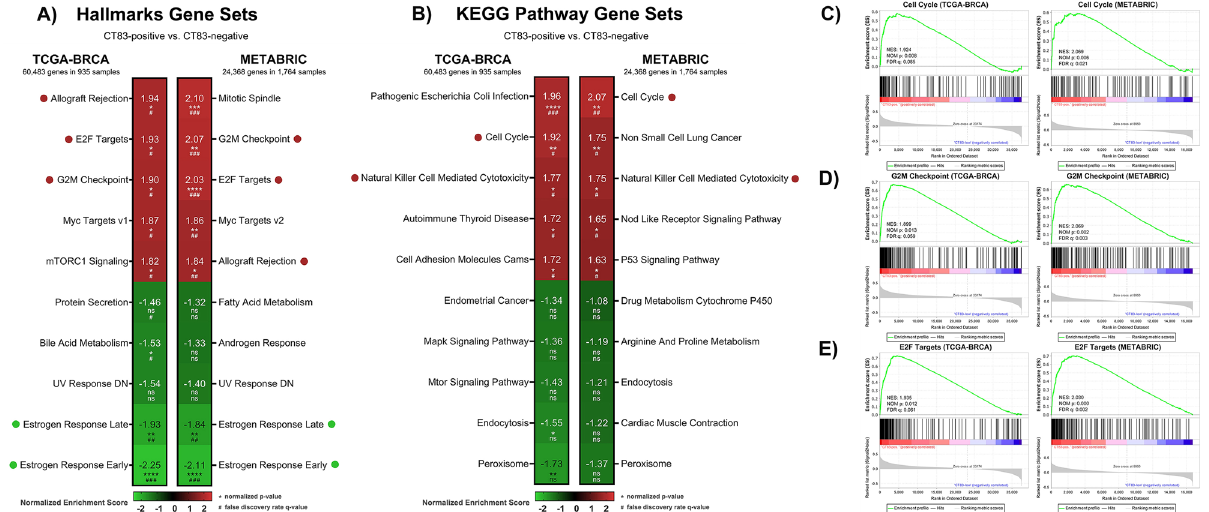
Figure 8. Bioinformatics prediction of CT83 biological functions in breast cancer by GSEA. GSEA of CT83 in breast cancer for ( A ) hallmark gene sets and ( B ) KEGG pathway gene sets using the TCGA-BRCA and METABRIC dataset. The red dots represent gene sets positively correlated with CT83 that are common in the TCGA-BRCA and METABRIC dataset with statistical significance, while the green dots were negatively correlated shared gene sets. Details of the three enriched gene sets associated with cell cycle signaling, namely ( C ) Cell Cycle, ( D ) G2M Checkpoint, and ( E ) E2F targets. Abbreviations: NES, normalized enrichment score; NOM p, normalized P -value; FDR q, false discovery rate q-value; *, p < 0.05; **, p < 0.01; ***, p < 0.001; ****, p < 0.0001; #, q < 0.25; ##, q < 0.05; ###, q < 0.01; ####, q <